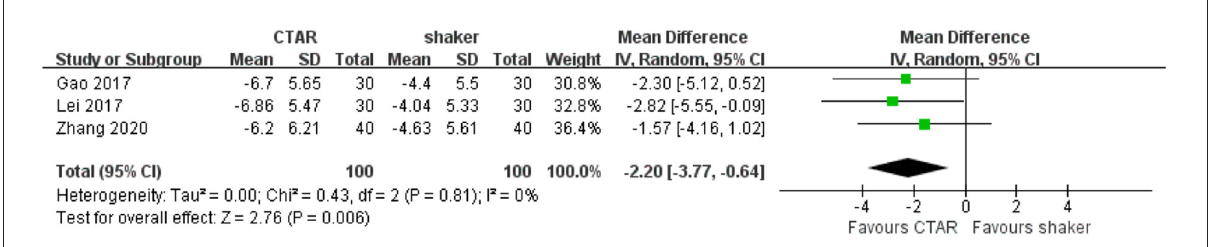
FIGURE7 Pooled changes of psychological condition in CTAR exercise vs. Shaker